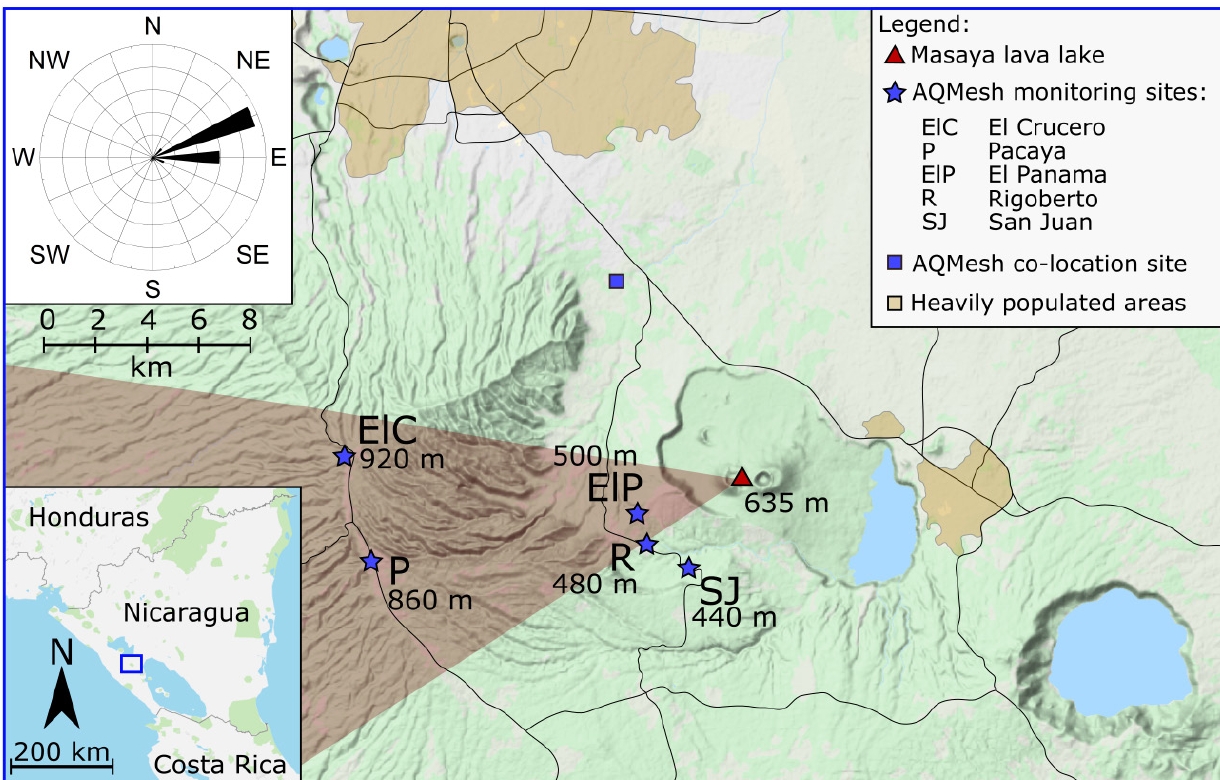
Figure 2: Topographic map of Masaya volcano and the AQMesh sampling stations with heights in metres above sea level (asl) for sampling stations and Masaya’s Santiago Crater. Upper left inset indicates the wind rose referring to 948 metres asl for the period February to August 2017, data derived from ECMWF forecast meteorological data. The red shaded area indicates prevailing plume dispersion, graphically presented from the most frequent (76 %) wind direction derived from ECMWF data at 948 metres asl. Lower left inset indicates geographical position of Masaya volcano. Base topographic map from Krogh